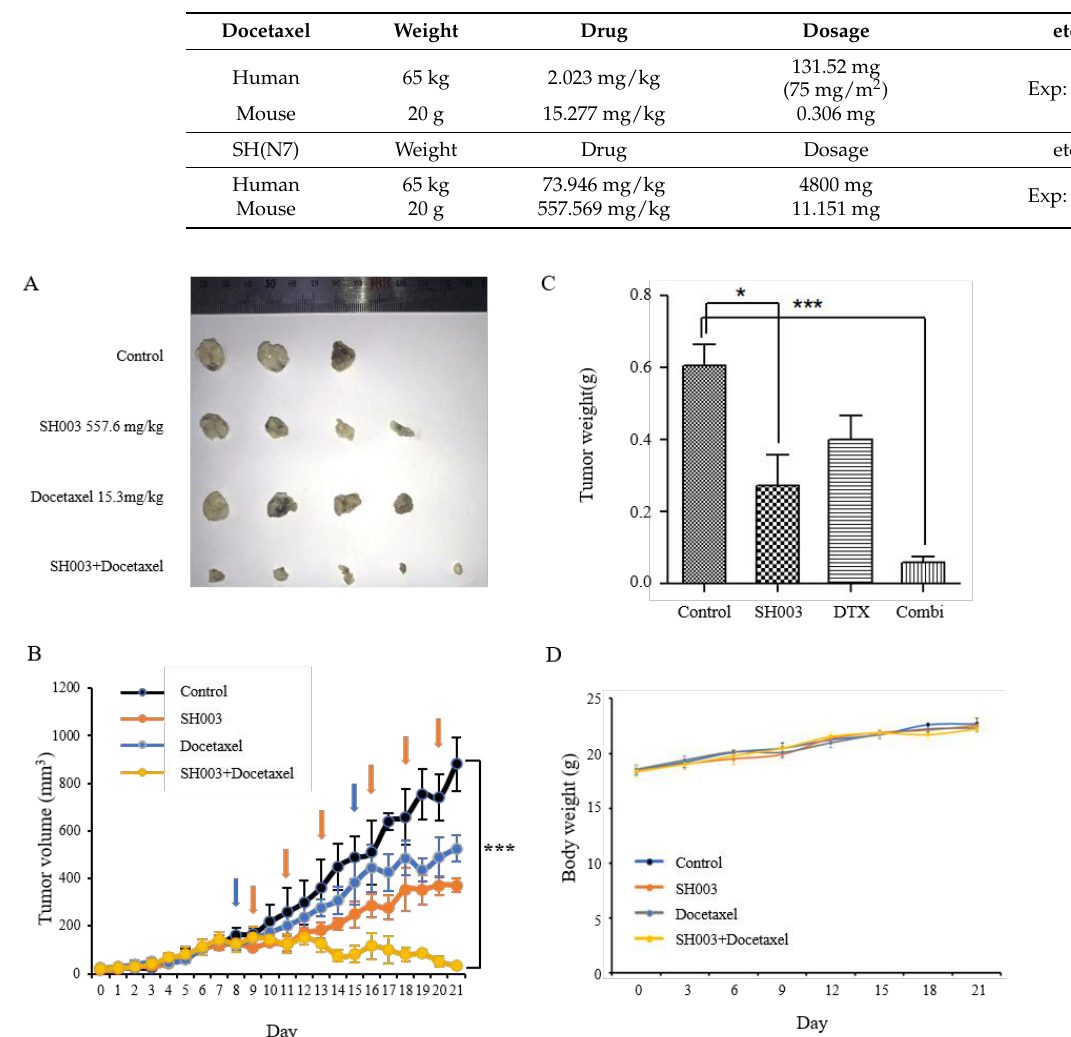
Figure 4. SH003 and docetaxel inhibited tumor growth in H460 xenograft mouse model in vivo. H460 cells (1 × 10 7 cells/mice) were inoculated subcutaneously and the growth of the implanted tumor in different groups of mice was calculated longitudinally. ( A ) Measurement of xenograft tumors volume. ( B ) Orange and blue arrows indicate treatment with SH003 and docetaxel, respectively. At the beginning, the tumors in the four groups grew similarly in all aspects for 1 week, whereas tumor growth was retarded in the SH003- and DTX-treated group until 2 weeks. On day 21, the mean tumor volume in the combination group was smaller than that in the control xenograft group. Statistical significance was deter- mined using the one-way ANOVA with Tukey’s test comparing control *** p < 0.001. ( C ) Tumor weights. Statistical sig- nificance was determined using the one-way ANOVA with Tukey’s test comparing control * p < 0.05 and *** p < 0.001 versus control. ( D ) The body weight was measured once every 3 days. The measured body weights between individual groups were similar.